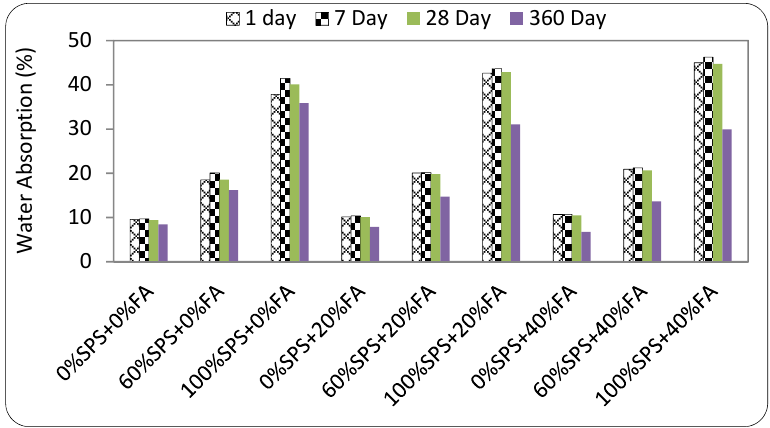
Figure 10. WA of concrete mixes at different curing periods.